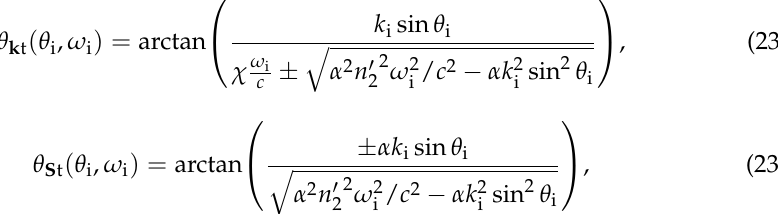
Figure 5. Wave scattering at the interface in Figure 1 for the parameters θ i = 60 ◦ , n (cid:48) Bottom-left panel: group velocity magnitude, phase velocity magnitude, and z -component of the group velocity, versus medium velocity. Bottom-right panel: group velocity and phase velocity angles versus medium velocity. The numbers (cid:172) , (cid:173) and (cid:174) indicate the segments of physical solutions, corresponding to v g z > 0, while the dashed lines indicate nonphysical solutions. Top panels: ray configurations corresponding to the velocity regions I-V , with magnitude and angles indicated in the other two figures (incident and reflected rays indicated only in the left-most